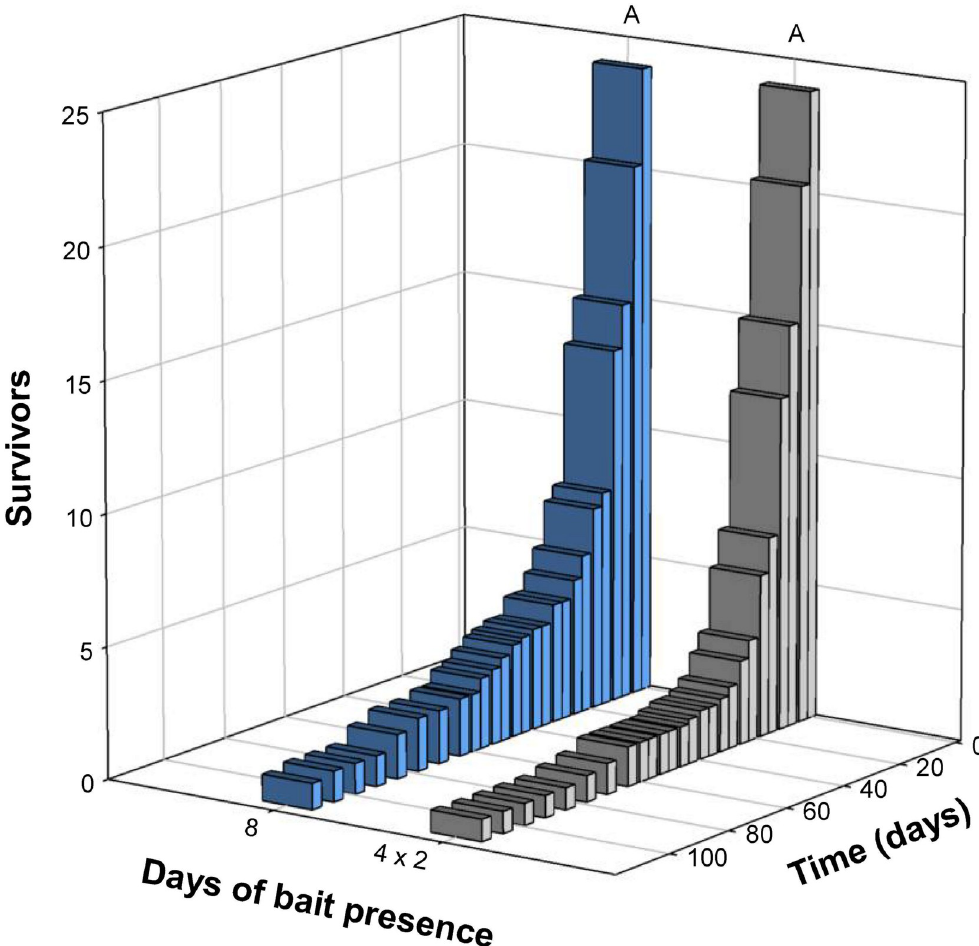
Fig 5. Survival of Ctenolepisma longicaudatum in population boxes of the 8-day continuous bait treatment and the 4 × 2-day bait treatment, respectively. The same letter (A) indicates a non-significant difference in survival between the two treatments (Kaplan–Meier survival analyses, p >